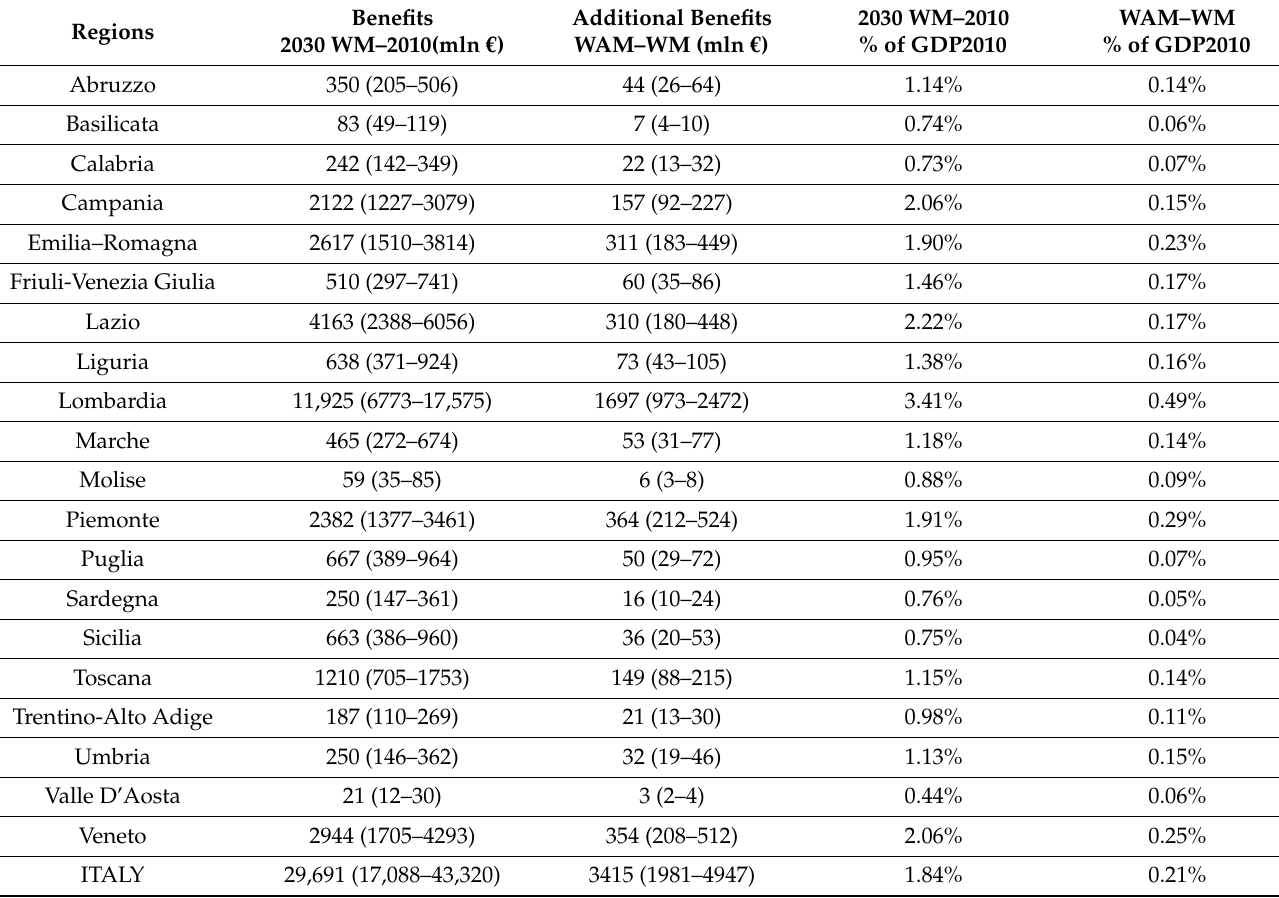
Table 11. Total and per pollutant benefit–costs (mln € ) of the 2030-WM scenario, compared to the base year 2010, and of the 2030-WAM scenario, compared to the 2030 WM; incidence of the benefits as percentage of the regional and national GDP2010.